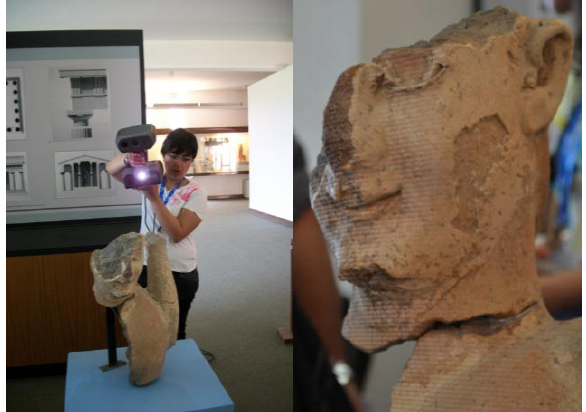
Figure 5. The Trimble Total Station